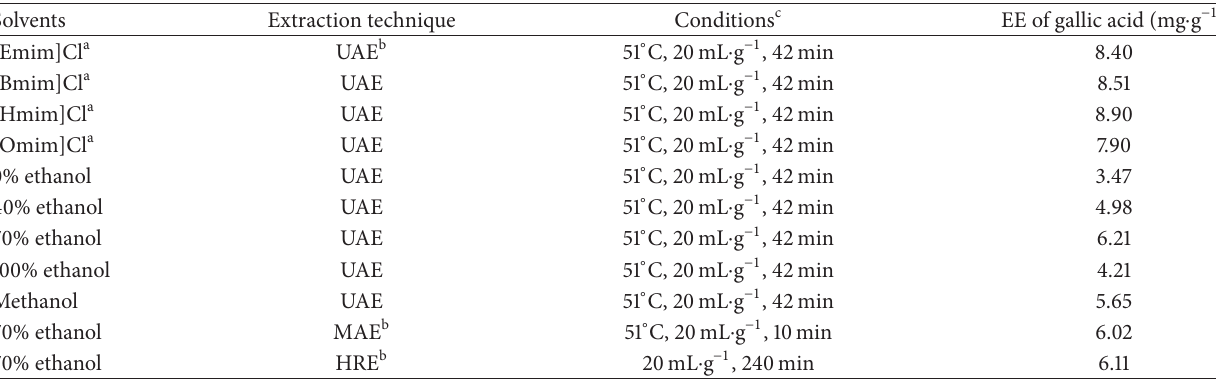
Table 3: Results of extraction of gallic acid by different solvents.